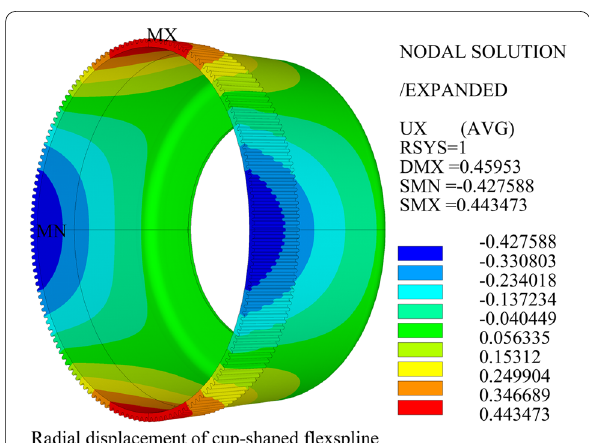
Figure 19 Nephogram of the radial displacement on cup-shaped FS